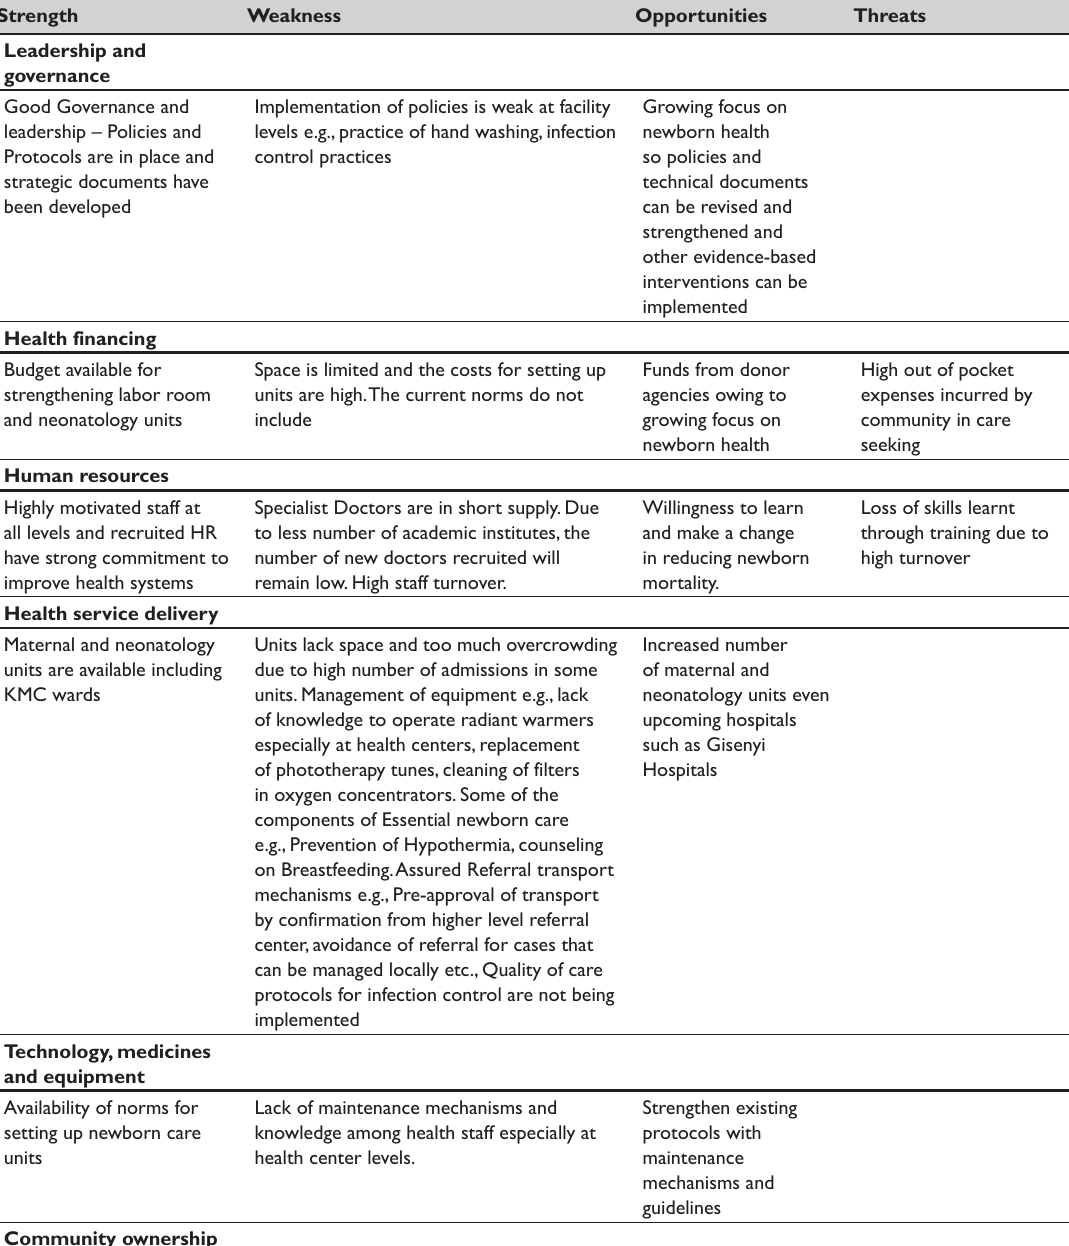
Table 4: Strength, weaknesses, opportunities and threat (SWOT)